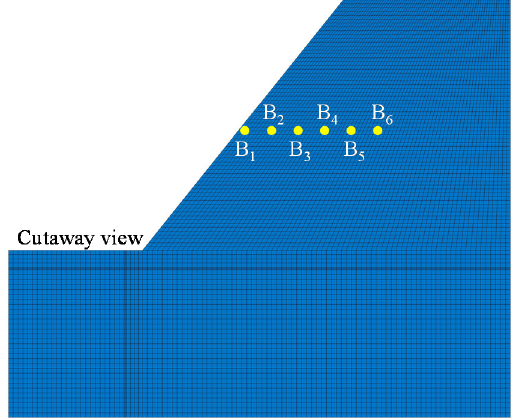
Figure 11. The feature points B 1 –B 6 .